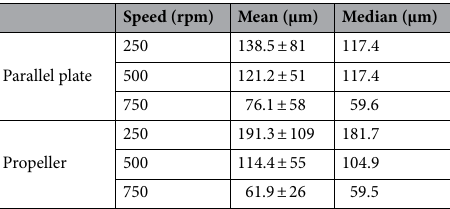
Table 1. Size distribution of microgels.